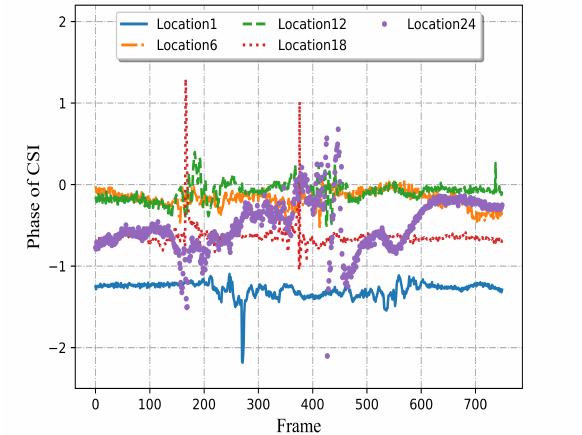
Figure 2. CSI amplitude of the same activity at five different locations.